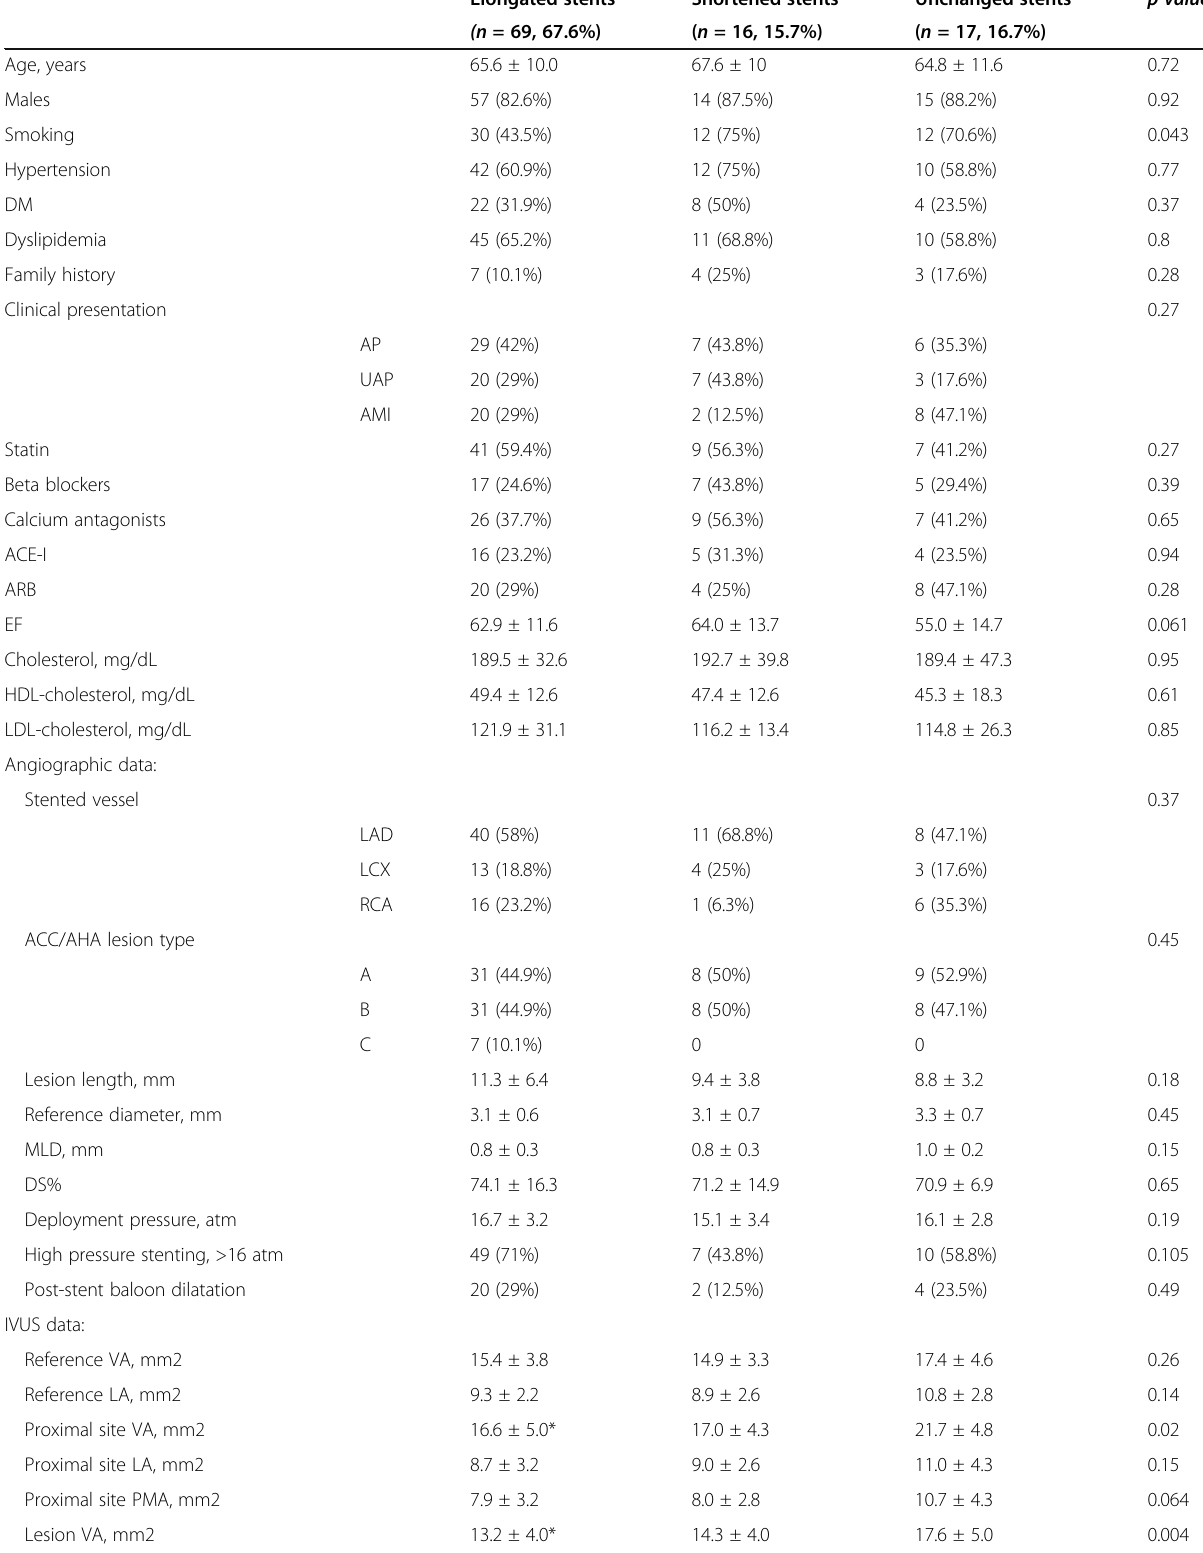
Table 1 Baseline characteristics by